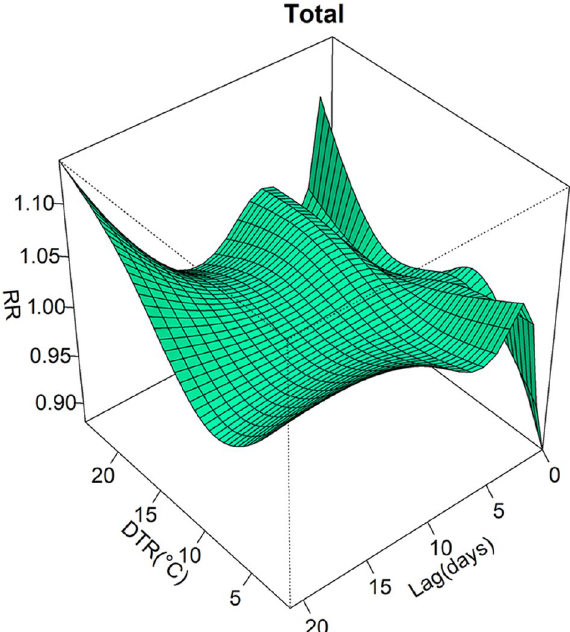
Figure 2. Relative risk of hospital admissions for CVD with DTR and lag (lag 0 to lag 21 days).